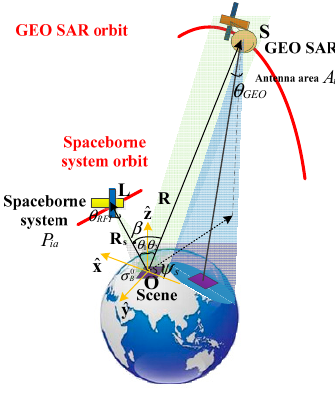
Figure 4. Sketch of the bistatic scattering RFI geometry.